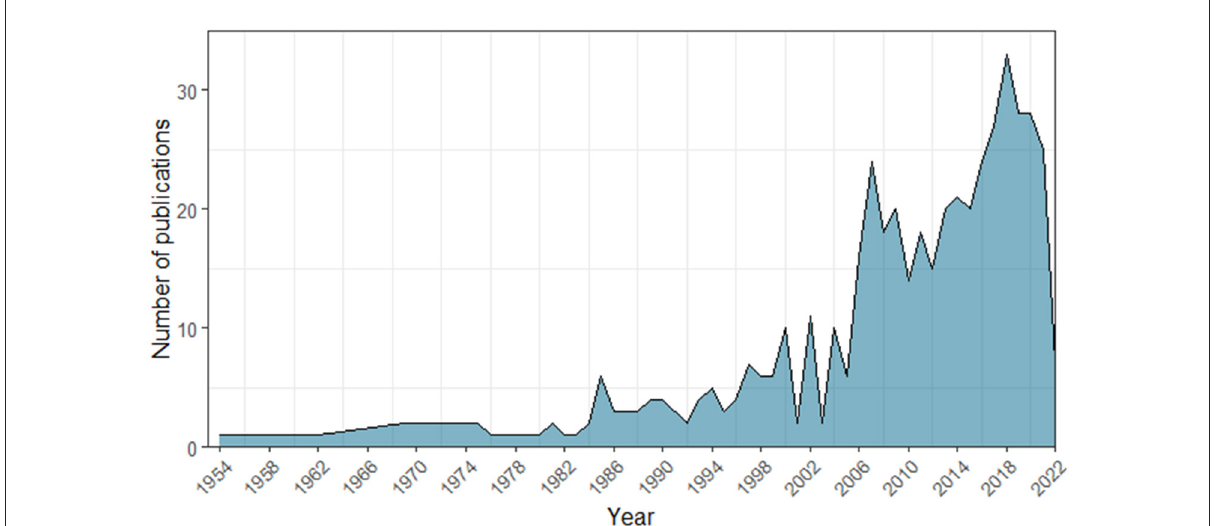
FIGURE1 Number of studies indexed in the Scopus and Web of Science databases that included the terms “duet” or “turn-taking” or “antiphonal calling” combined with the words “animal” or “non-human” or “Animalia” or “fauna” across years (1954–2022).